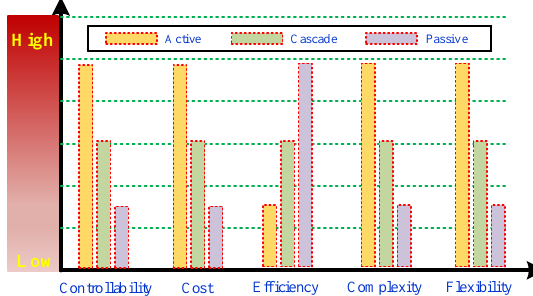
Figure 11. The comparison of various hybrid storage